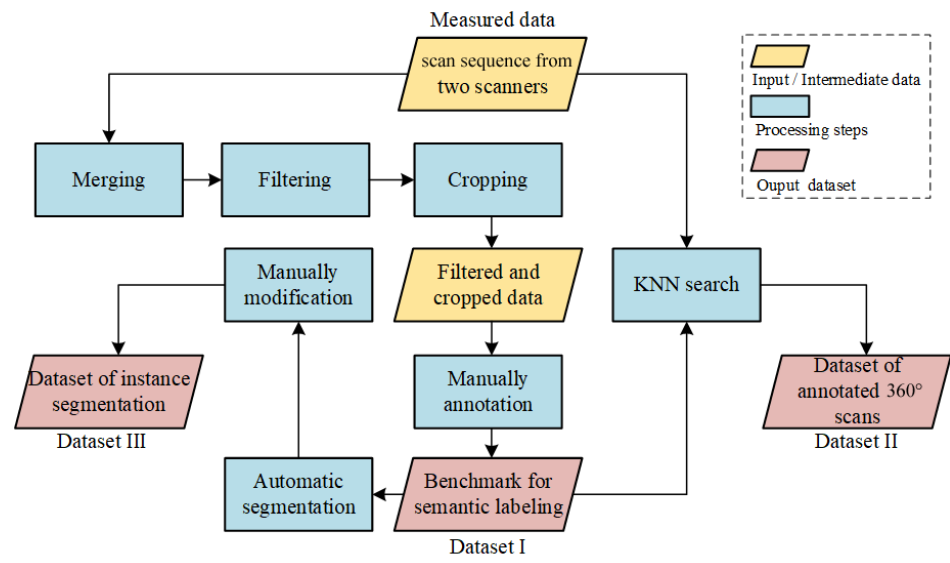
Figure 4. Workflow of the creation of three labeled datasets from the original MLS